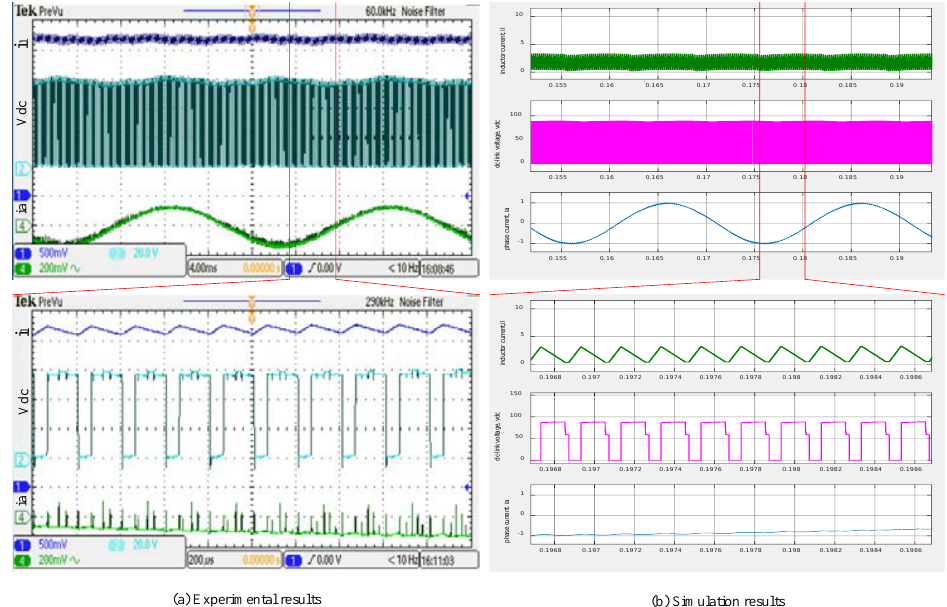
Figure 29. Inductor current, dc-link voltage, and load current of one phase. For checking the experimental results, the corresponding simulations have also been obtained. From the shown figures, it can be observed that both simulation and experimental results are in good agreement for all cases. The following notes can be